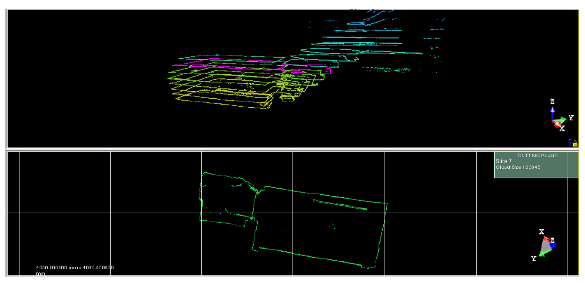
Figure 16. 3D cross-sections and 2D metric